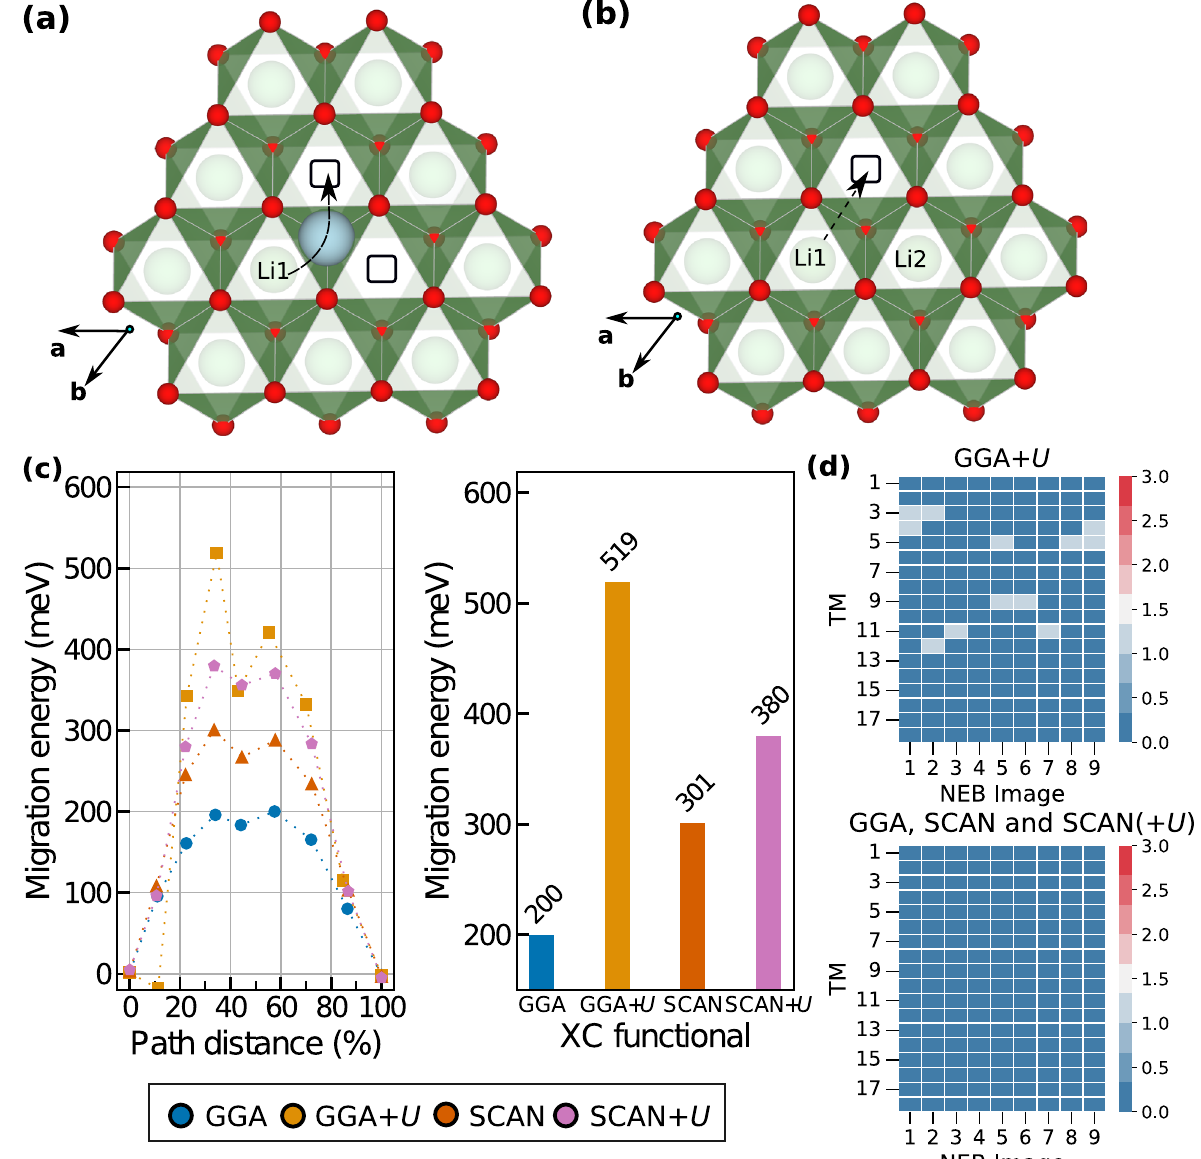
Fig. 6 MEPs and the corresponding barriers for LiCoO 2 . a , b display the divacancy and monovacancy Li migration mechanisms, respectively, in LiCoO 2 . c Calculated MEPs and E m . d On-site magnetic moment changes of the Co ions as a function of Li-ion migration with the GGA + U (top panel) and GGA/SCAN/SCAN + U functionals (bottom